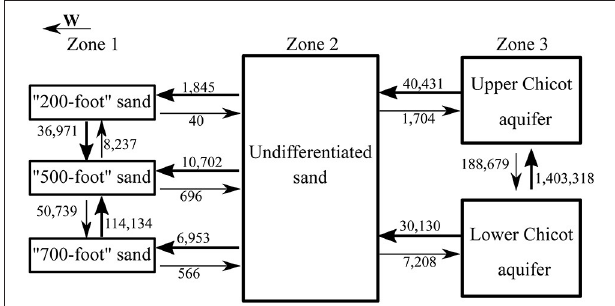
FIGURE 14 | Intra-annual monthly groundwater level variation for different sands in the Chicot aquifer system from 2005 to 2014. The groundwater level datum is NAVD 88.